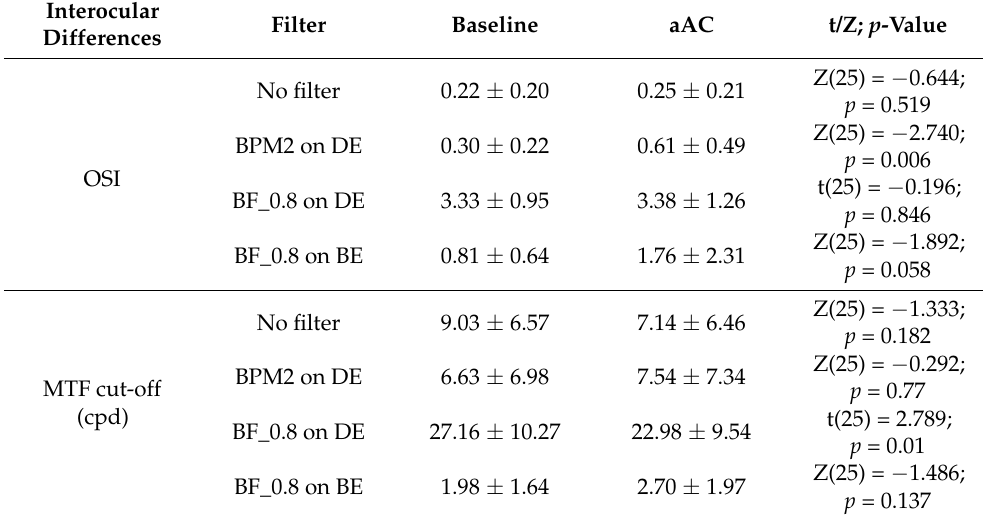
Table 3. Mean values of the interocular differences for the ocular parameters analyzed: objective scatter index (OSI), modulation transfer function cut-off (MTF cut-off), Strehl ratio (SR) and straylight (log(s)) under the different experimental conditions: baseline (no alcohol consumption) and aAC (after alcohol consumption) and for different filter conditions: no filter, BPM2 fog filter on the dominant eye (BPM2 on DE), Bangerter foil BF_0.8 on the dominant eye (BF_0.8 on DE) and BF_0.8 on both eyes (BF_0.8 on BE). Standard deviations are included and statistical results (t/Z) and p -values are